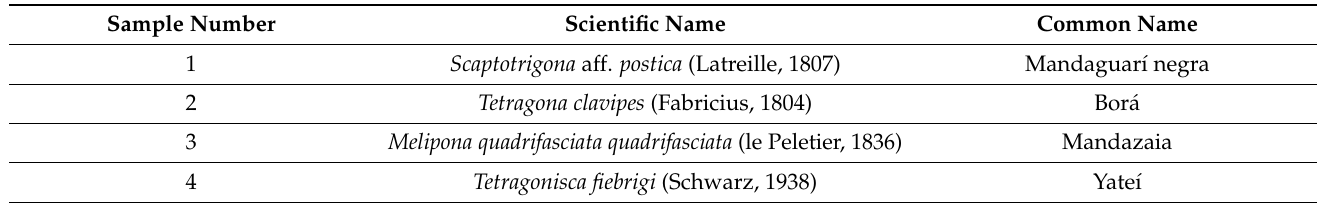
Table 1. Scientific and local names of bees whose propolis was